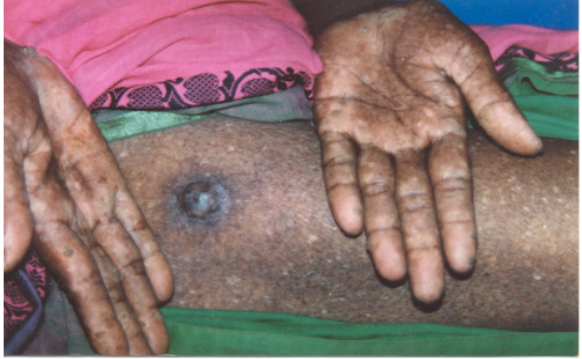
Figure 4: A 42-year old woman having characteristic raindrop skin lesions on her both extremities and a nodule on her thigh [36].